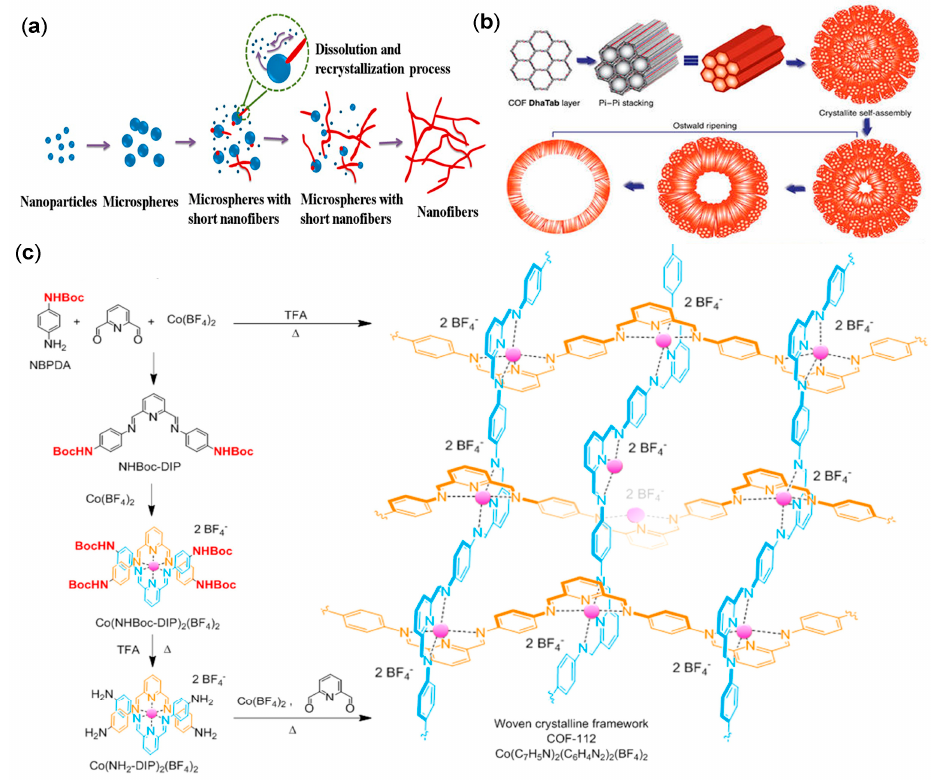
Figure 8. Schematic representations of the formation of ( a ) nanofibers, reproduced with permission from [237]. Copyright American Chemical Society, 2013; ( b ) hollow spheres, reproduced with permission from [116]. Copyright Springer Nature, 2015; ( c ) weaving COFs, reproduced with permission from [202]. Copyright American Chemical Society, 2017.